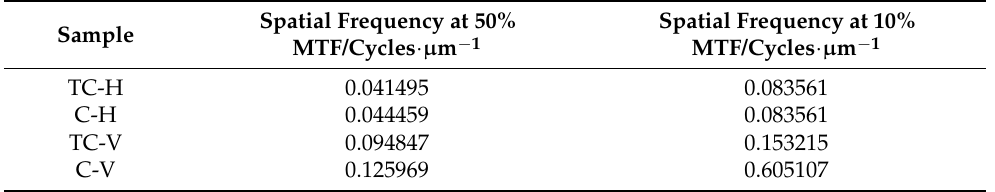
Table 4. Spatial frequencies at 50% MTF values and 10% MTF values for thermochromic horizon- tal edge (TC-H), conventional horizontal edge (C-H), thermochromic vertical edge (TC-V), and conventional vertical edge